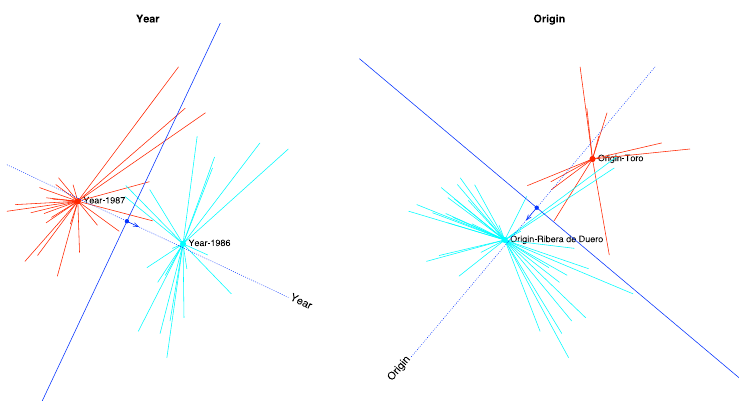
Figure 8. Prediction regions for each separate variable.